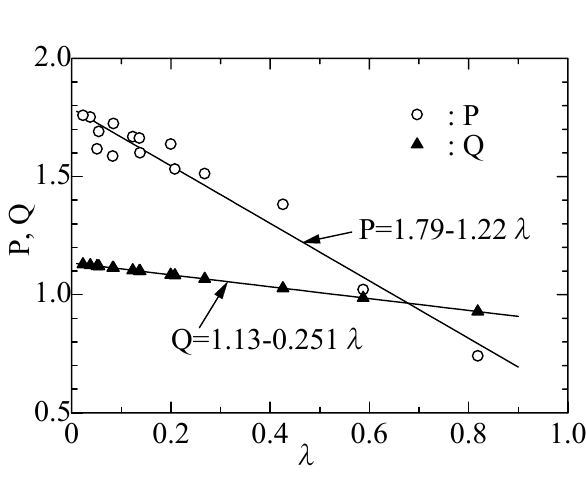
Fig.4 Example of obtained ψ